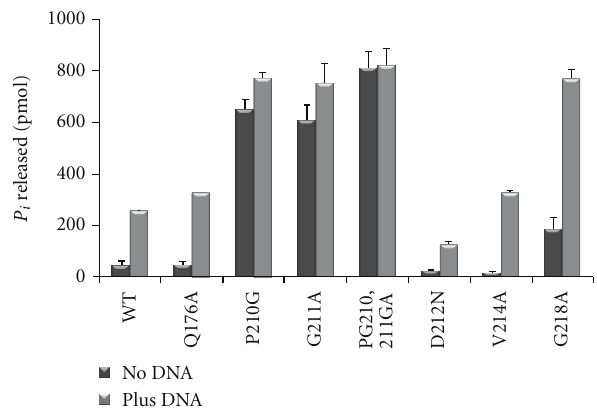
Figure 5: ATPase activity by the mutant MCM proteins. ATPase activities of wild-type and mutant MCM proteins were determined as described in “Section 2” using 30nM of MCM (as monomer) in the presence or absence of 50ng of ssDNA. The average results of three independent experiments with standard deviations are